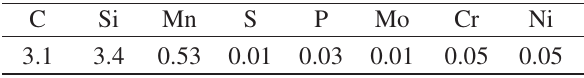
Table 1. Chemical composition of the SG cast iron (wt. %).